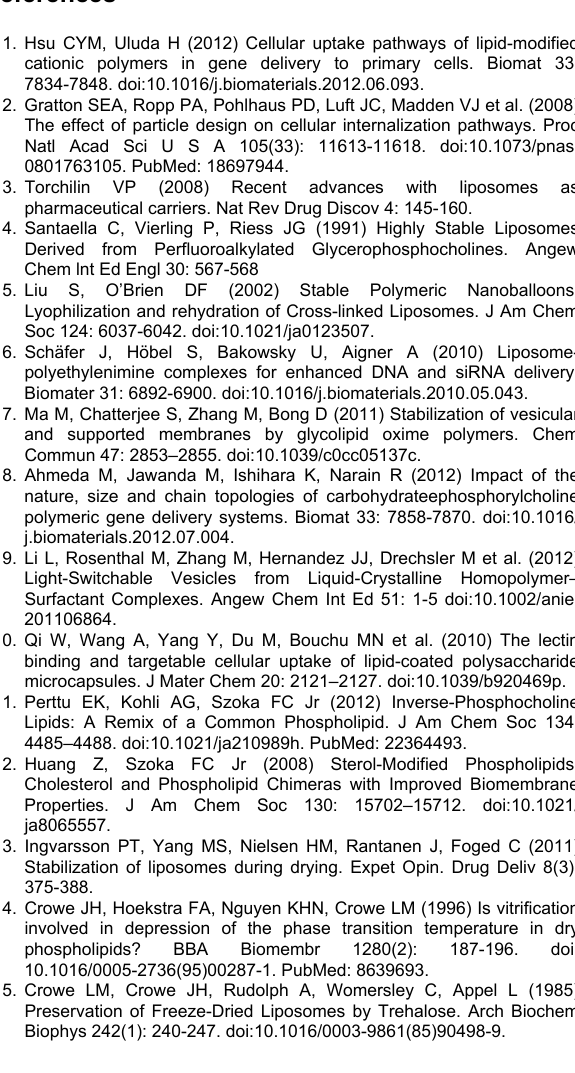
Figure S1. Structural elucidation of Ptd-Glu. ( A ) Base-peak and extracted ion chromatograms and full FTMS spectrum of Ptd-Glu. ( B ) MS 2 spectra of the two major isomers. The primary fragments are the loss of the glycan-unit, loss of C the glycan ring and loss of glycan and one fatty acid. ( C ) Structure of Ptd-Glu (D-1). 13 C- 1 H HSQC spectrum of Ptd-Glu, showing chemical shifts of the α- and β-conformer of the glucose unit (D-2). 31 P- 1 H HMBC spectrum of Ptd-Glu, showing correlations between phosphorous and the H H αglycerol protons.